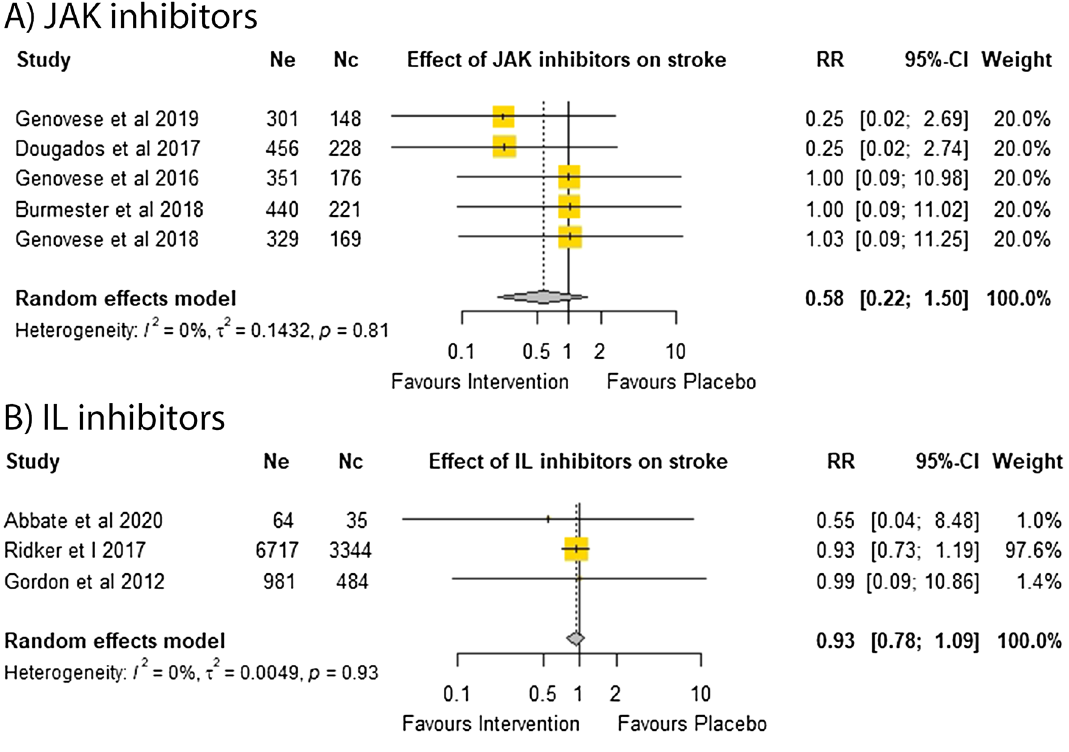
Figure 4. Effect of DMARDs on stroke